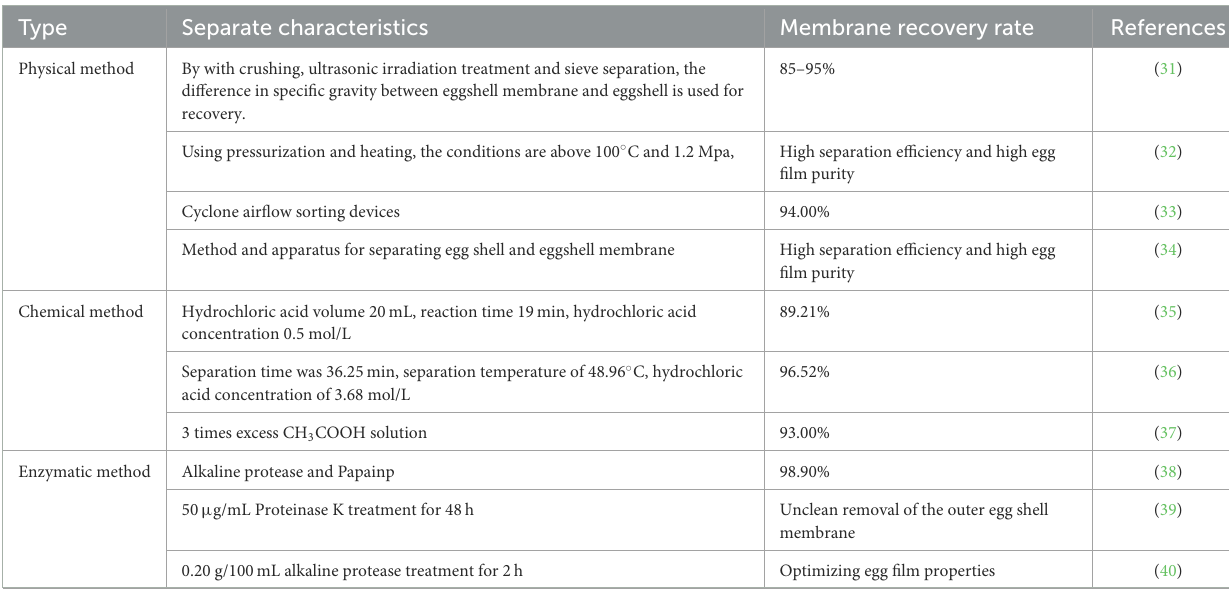
TABLE 2 Typical shell membrane separation technology